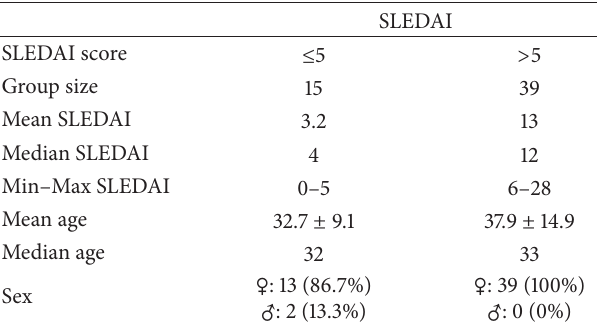
Table 1: Characteristics of the study group in terms of age, gender, and disease activity measured by SLEDAI